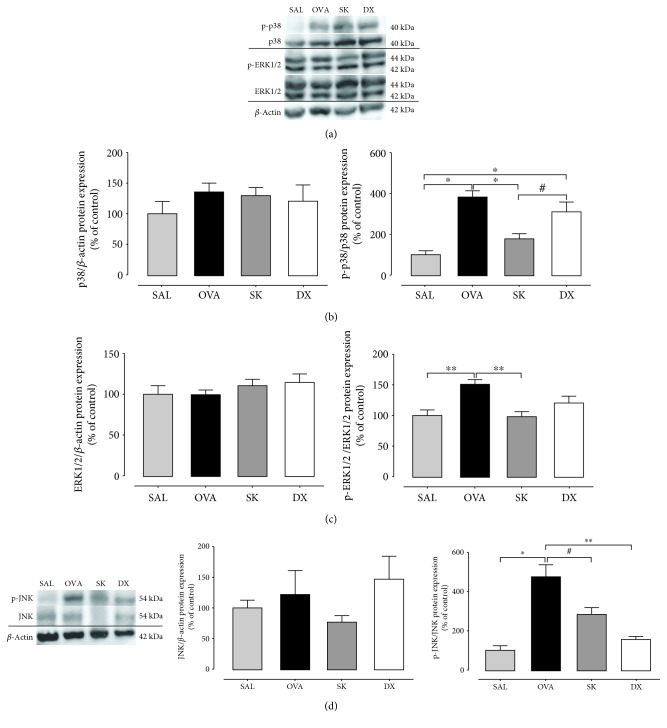
Sakuranetin inhibits the activation of the MAPK pathway. (a) Image intensity of p38, p-p38, ERK1/2, and p-ERK1/2. (b) Expression of p38 and p-p38. (c) Expression of ERK1/2 and p-ERK1/2. (d) Expression and image intensity of JNK and p-JNK in lung tissue measured by immunoblotting. Sakuranetin reduced the phosphorylation of p38, ERK1/2, and JNK that was enhanced in the asthmatic group. ∗p < 0.001, ∗∗p < 0.01, and #p < 0.05. Data represent mean ± SEM from 5 to 8 mice per group.